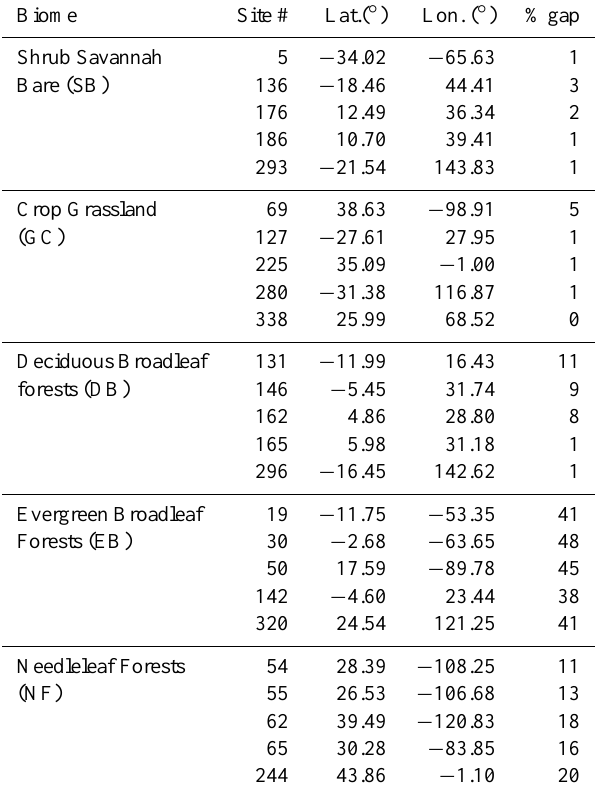
Table 2. Sites selected for the study for the 5 biomes. The site num- ber in BELMANIP2 ensemble of 420 sites, latitude and longitude and fraction of missing data (%gap) are indicated.